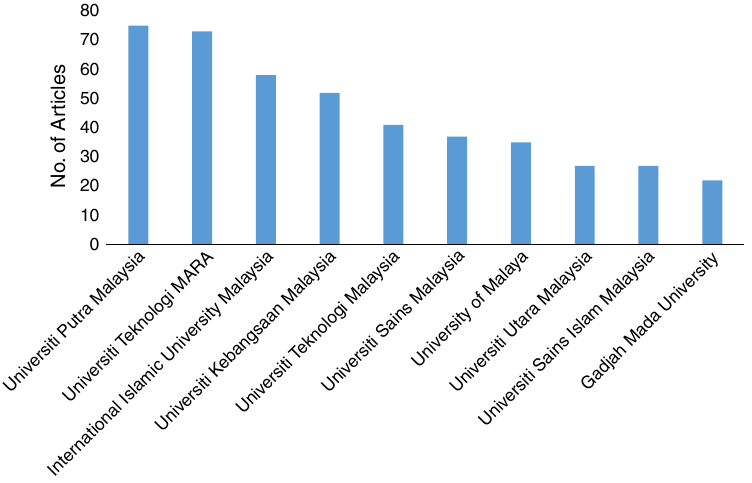
Figure 2. Major universities contributing to